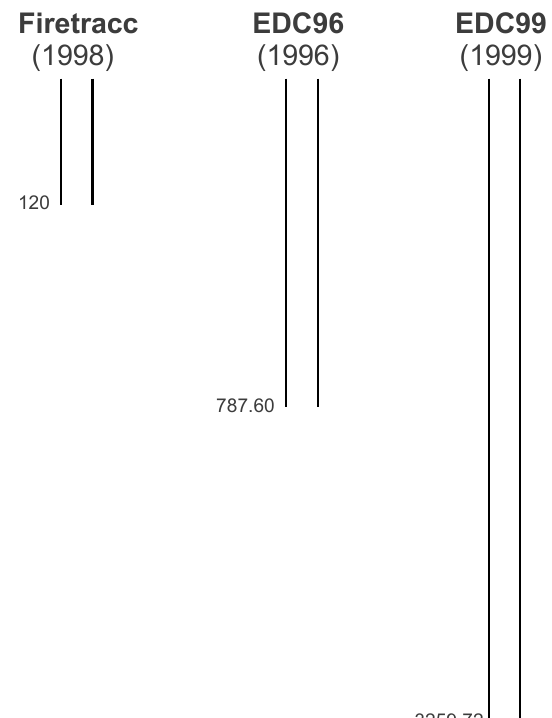
Fig. 1. Scheme of the different EDC ice cores. The depths indicated are the maximum logging depths.